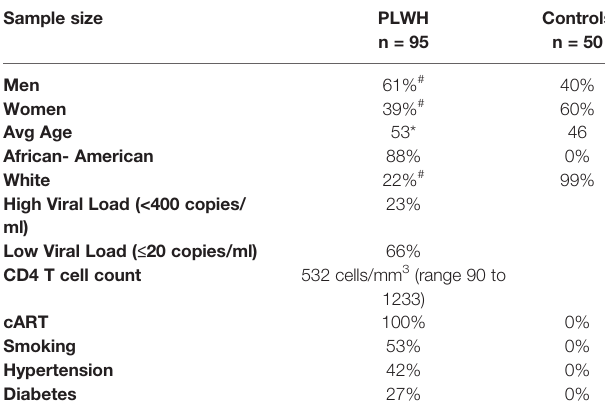
TABLE 1 | General demographics of study cohort subjects. Sample